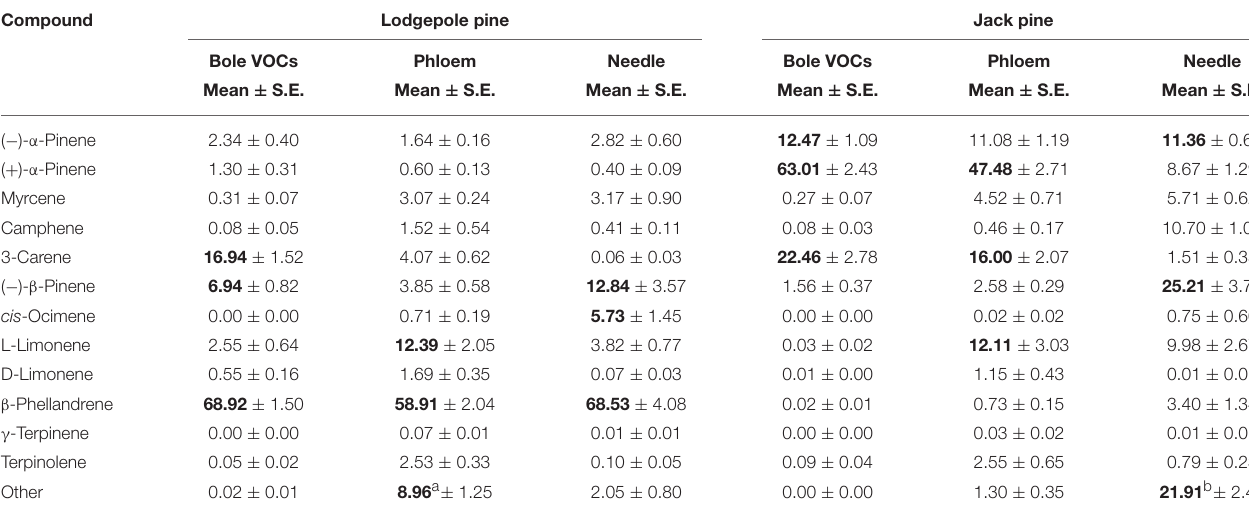
TABLE 1 | Chemical profiles (ratios %) of bole volatiles (VOCs) of all untreated control trees throughout the experiment, phloem from the start and end of the experiment without biological treatment, and needle extracts of control trees from the day of harvest 2010. Compound Lodgepole pine Jack pine Bole VOCs Phloem Needle Bole VOCs Phloem Needle Mean ± S.E. Mean ± S.E. Mean ± S.E. Mean ± S.E. Mean ± S.E. Mean ± S.E.